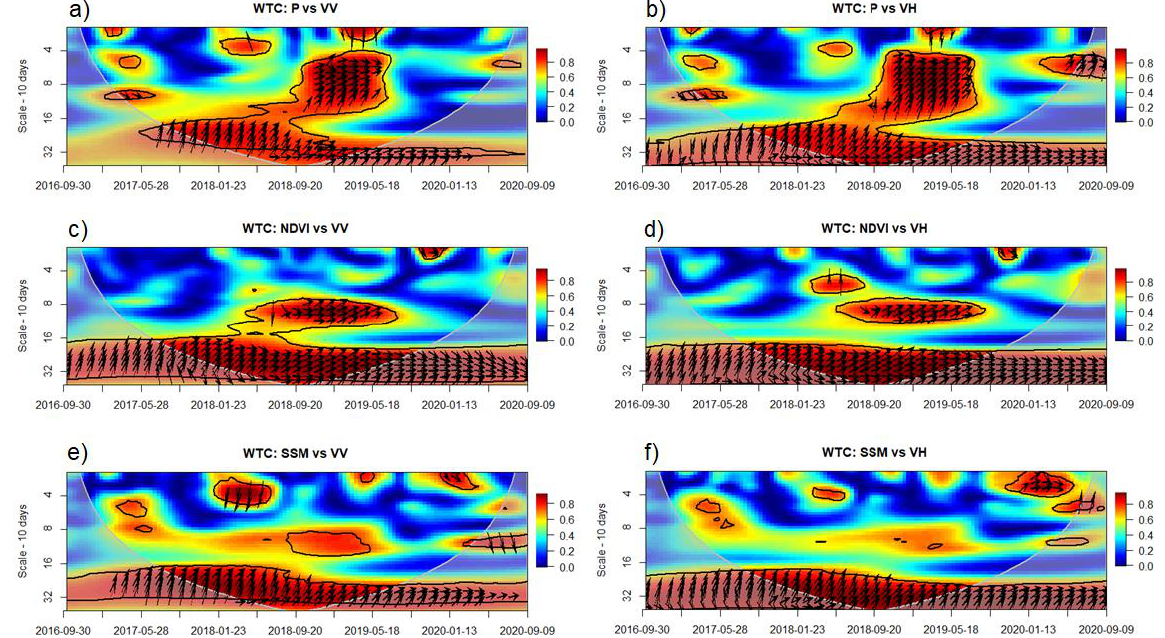
Figure 13. Wavelet transform coherence (WTC) between ( a ) P and VV, ( b ) P and VH, ( c ) NDVI and VV, ( d ) NDVI and VH, ( e ) SSM and VV, and ( f ) SSM and VH. Notes: time is displayed on the hori- zontal axis, frequency on the vertical axis; warmer colors (red) represent high power signals, and